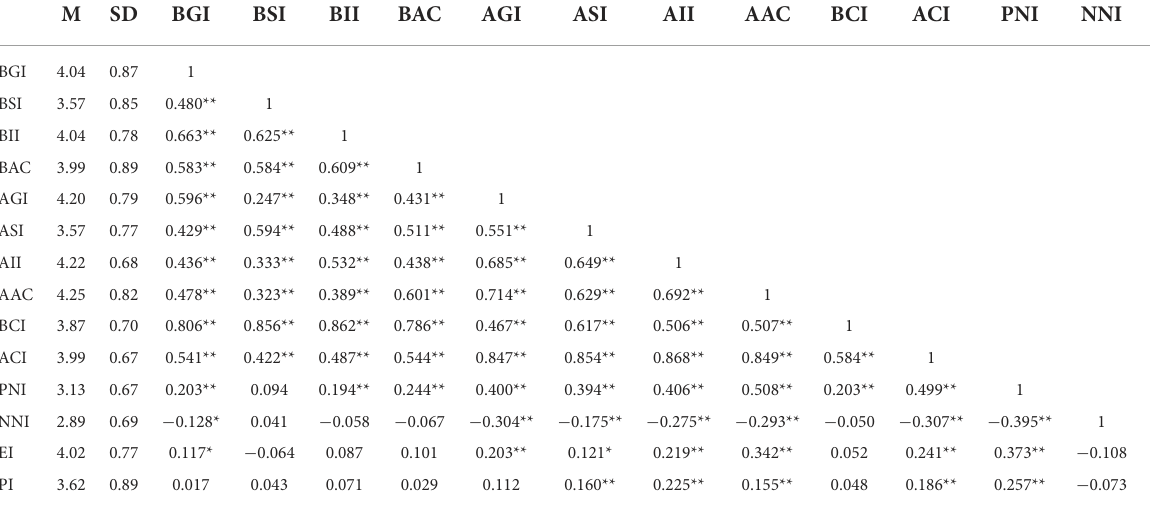
TABLE 6 The means, standard deviations, and correlations.